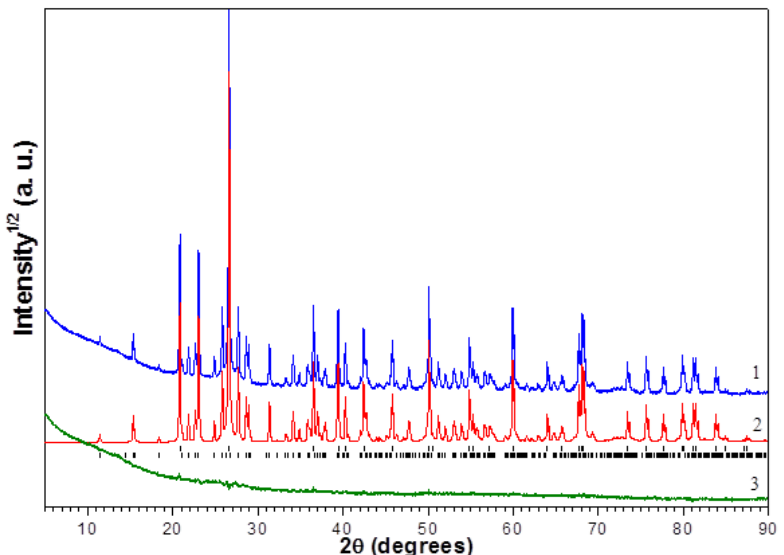
Figure 4. X-ray diffraction pattern of a sample of 70% marshalite − 30% sulfur, curves: experimental (1), calculated (2) and difference (3). (2-column fitting image).